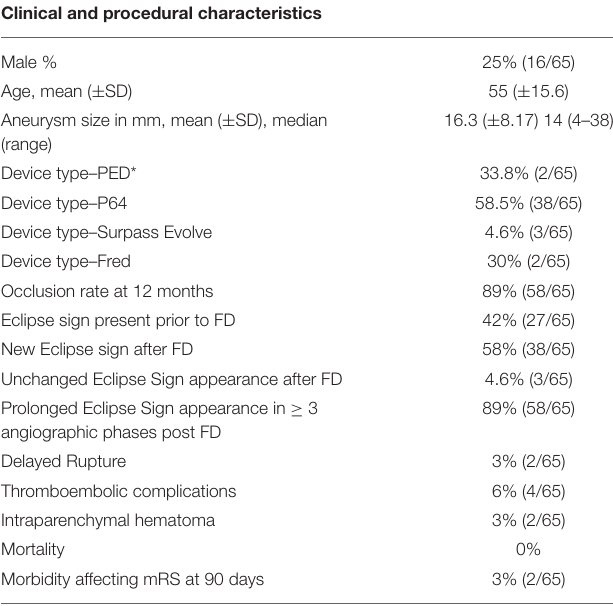
TABLE 1 | Clinical and procedural characteristics. Clinical and procedural